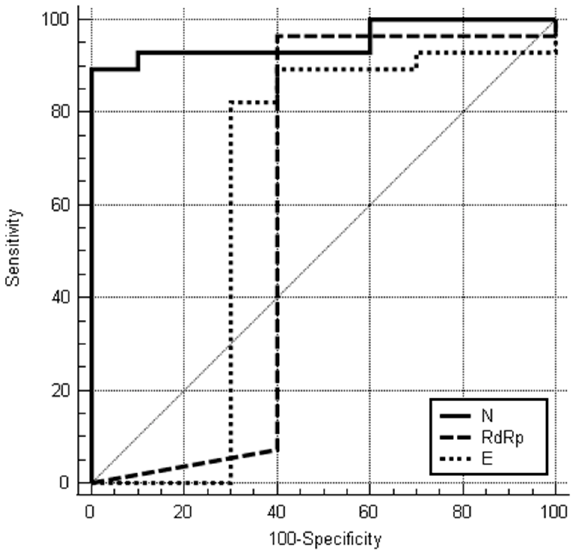
Figure 3. The ROC curves of Ct value for each gene through RT-PCR test. Abbreviations: ROC, receiver operating characteristic; Ct, cycle threshold; RT-PCR, reverse transcription polymerase chain reaction.